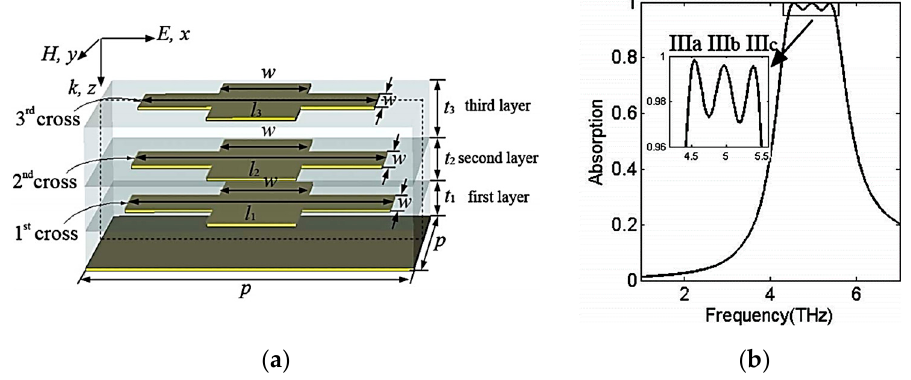
Figure 18. ( a ) Structure of multilayer broadband absorber; ( b ) the absorption curve [40]. In 2022, Li et al. designed an ultra-wideband absorber with stacked round hole discs [56], as shown in Figure 19. Ultra-wideband absorption can be realized in the whole spectrum (0.25 µ m–4 µ m). Due to the plasma resonance, the absorber’s absorption rate is more than 90% in the ultra-wide spectral range of 3450 nm, the average absorption rate is 97.5%, and the average absorption rate in the visible light range is more than 99%. Therefore, the absorber shows good performance in the field of solar energy collection and conversion.